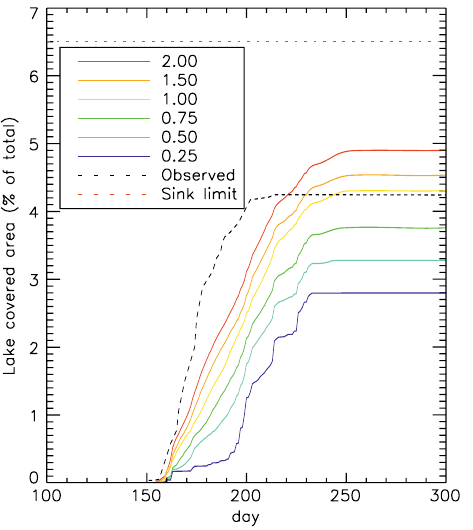
Fig. 6. Sensitivity analysis with respect to runoff amount for the 1100–1700m elevation band of lake area. Presented here are lake area profiles simulated using the full runoff amount and scaling fac- tors of 2, 1.5, 0.75, 0.5, and 0.25 applied to the full runoff amount. Also shown is the observed cumulative lake area profile (black dashed) and the maximum possible lake-covered area, calculated by filling all sinks (red dashed).